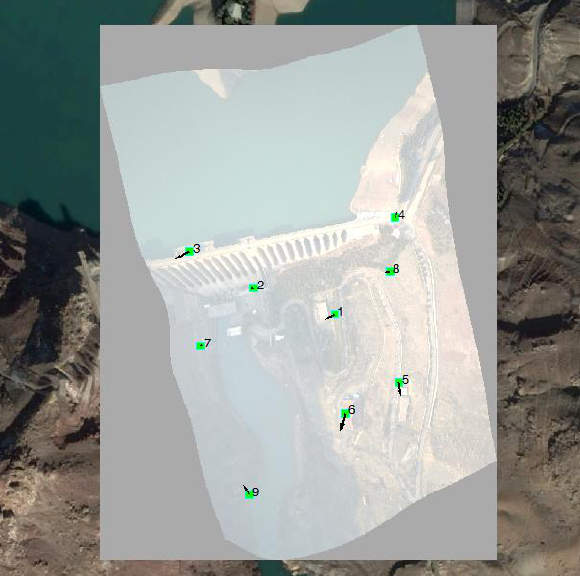
Figure 11. Residual vectors obtained by differencing control point positions in the case of geo-located image resulted from fine geo-location process